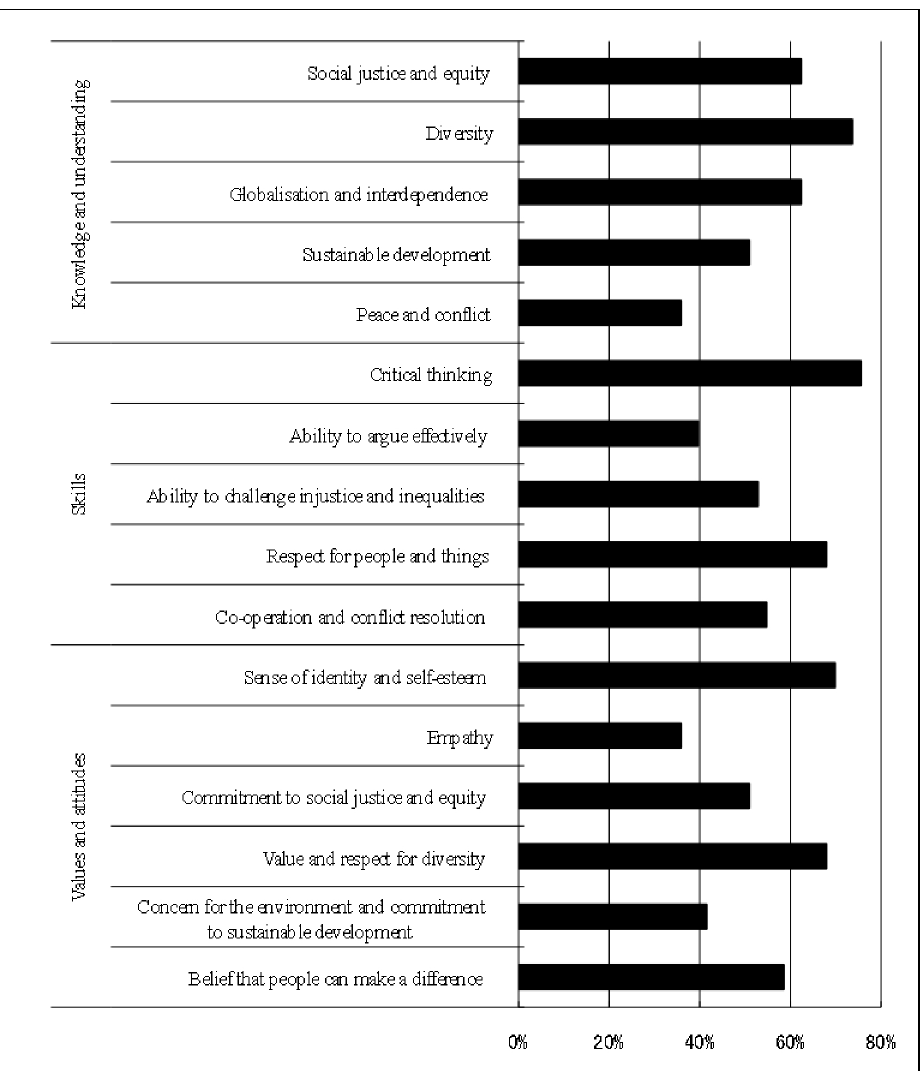
Figure 3:The degree of agreement (includes agree and strongly agree) of the development of elements of Oxfam’s responsible global